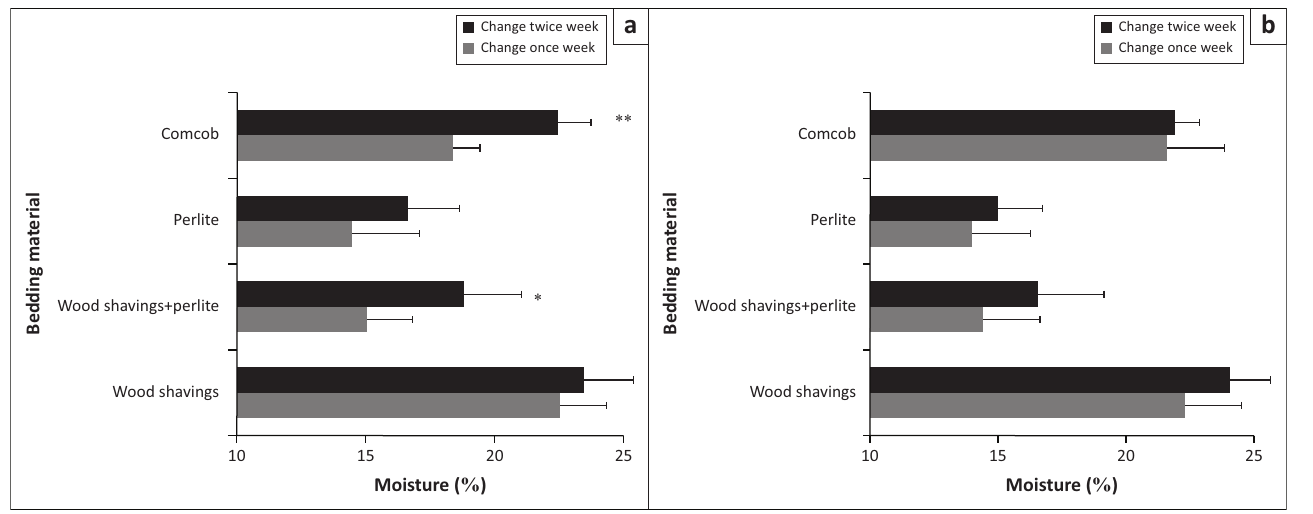
FIGURE 1: Body weight differences between groups according to sex ([a] male and [b] female), frequency of bedding change and bedding material.